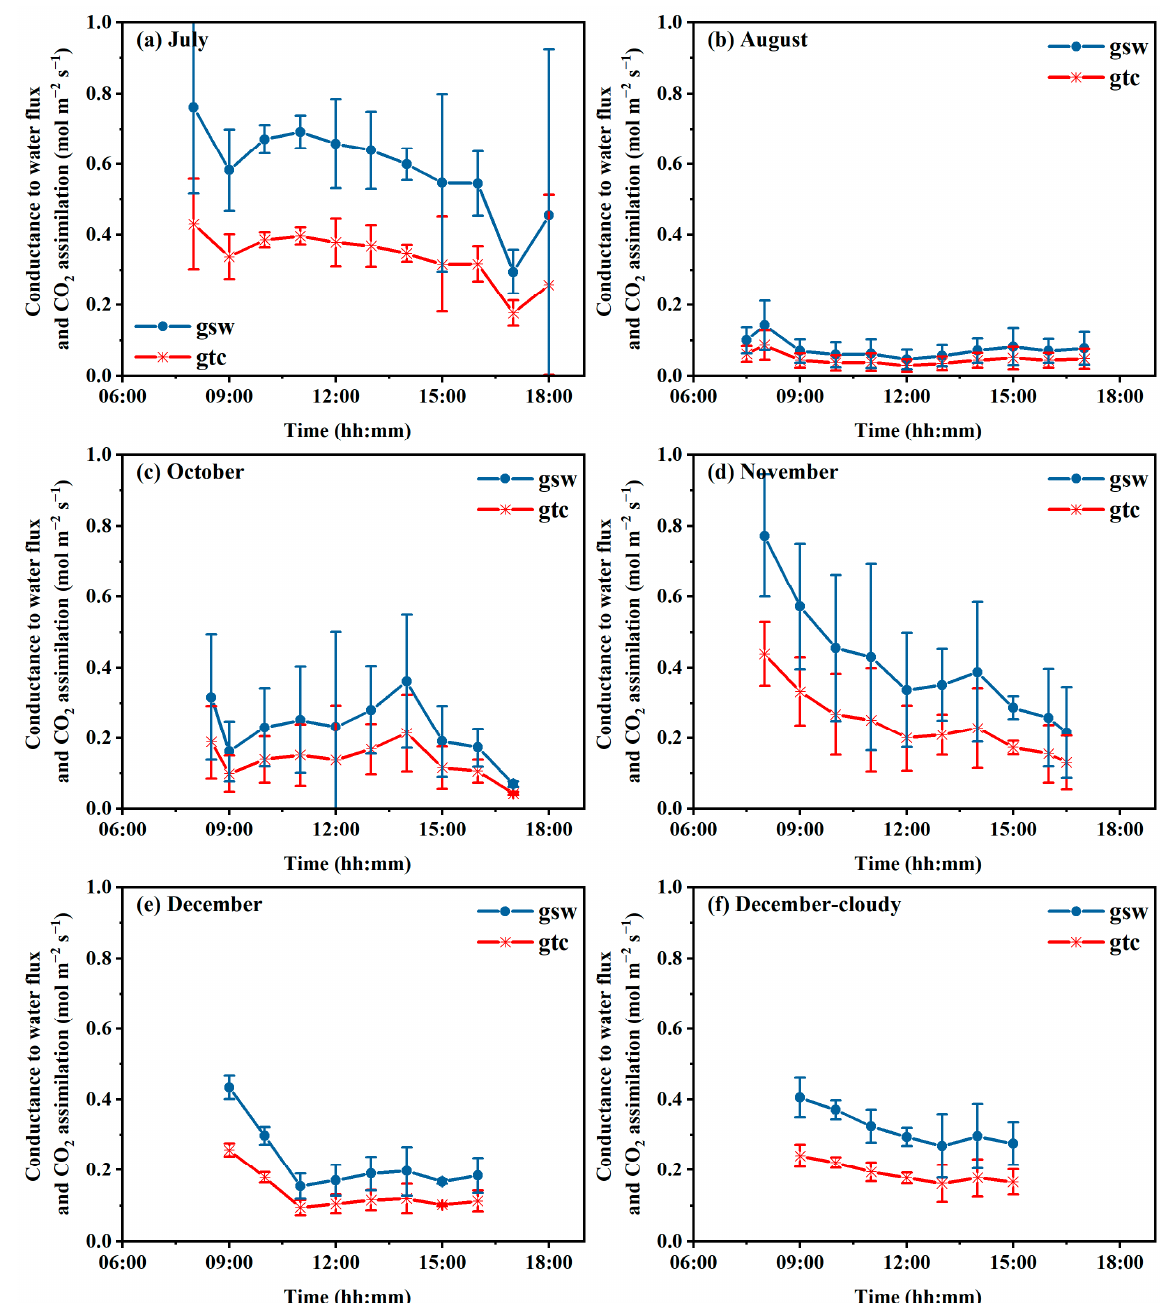
Figure 4. Daily courses of stomatal conductance for transpiration and photosynthesis rates in July ( a ), October ( c ), November ( d ) and December ( e ) for healthy plants on sunny days, in August ( b ) for diseased plants on sunny days and in cloudy days with healthy plants ( f ).